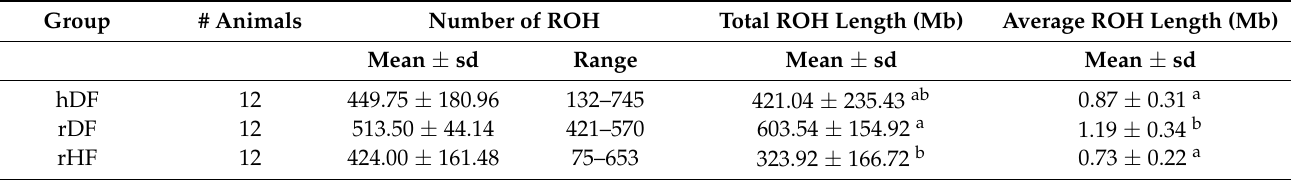
Table 4. Summary of specific regions of homozygosity (ROHs) in the three groups.